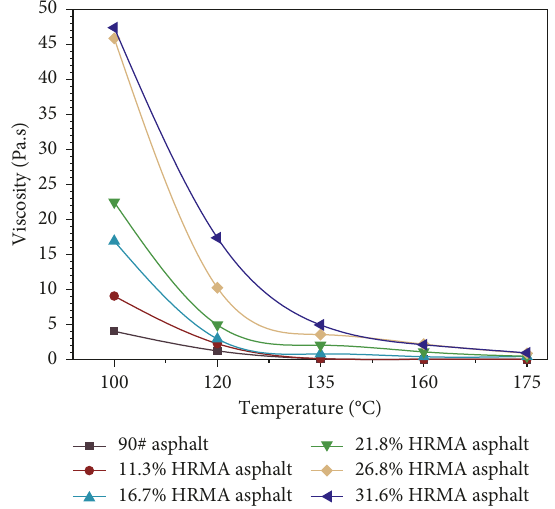
Figure 10: The viscosity of asphalt binders versus temperature under different HRMA